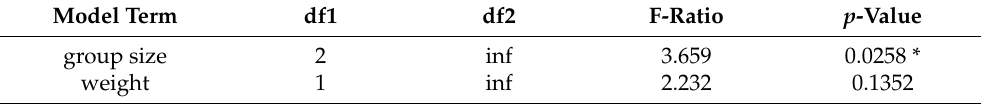
Table 3. Results of F-test for the logistic regression model with lesions of kits as dependent variable. Model Term